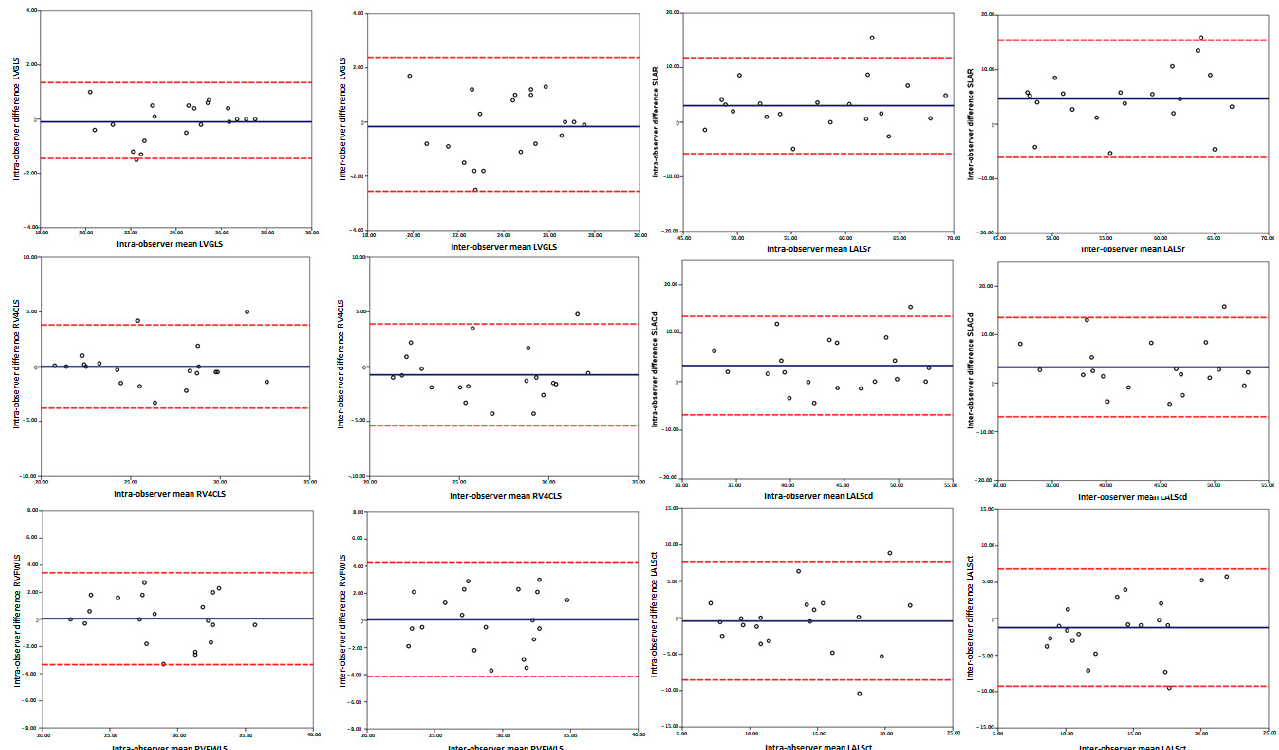
Figure 3. The Bland-Altman plots of the intra- and inter-observer measurements. LVGLS: Left ventricle global longitudinal strain, RVFWLS: Right ventricle free wall longitudinal strain, RV4CLS: Right ventricle four chamber longitudinal strain, LALSr: Left atrial longitudinal strain reservoir phase, LALScd: Left atrial longitudinal strain conduct phase, LALSct: Left atrial longitudinal strain contraction phase.